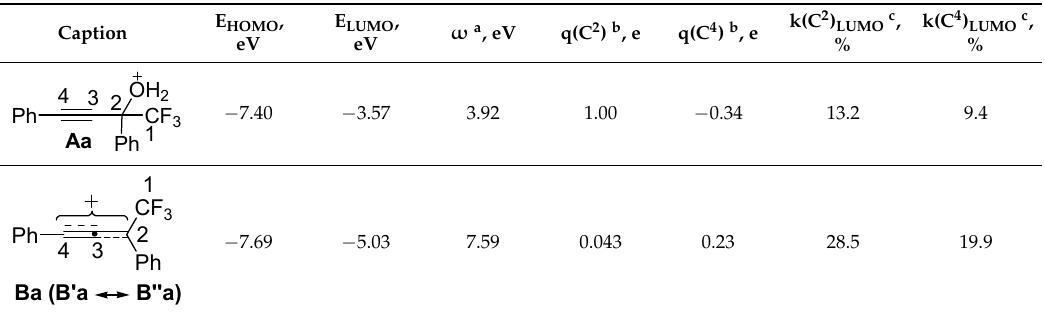
Table 1. Selected electronic characteristics (DFT calculations) of cations Aa and Ba ( B ′ a ↔ B ″ a ) derived at the protonation of alcohol 1a .